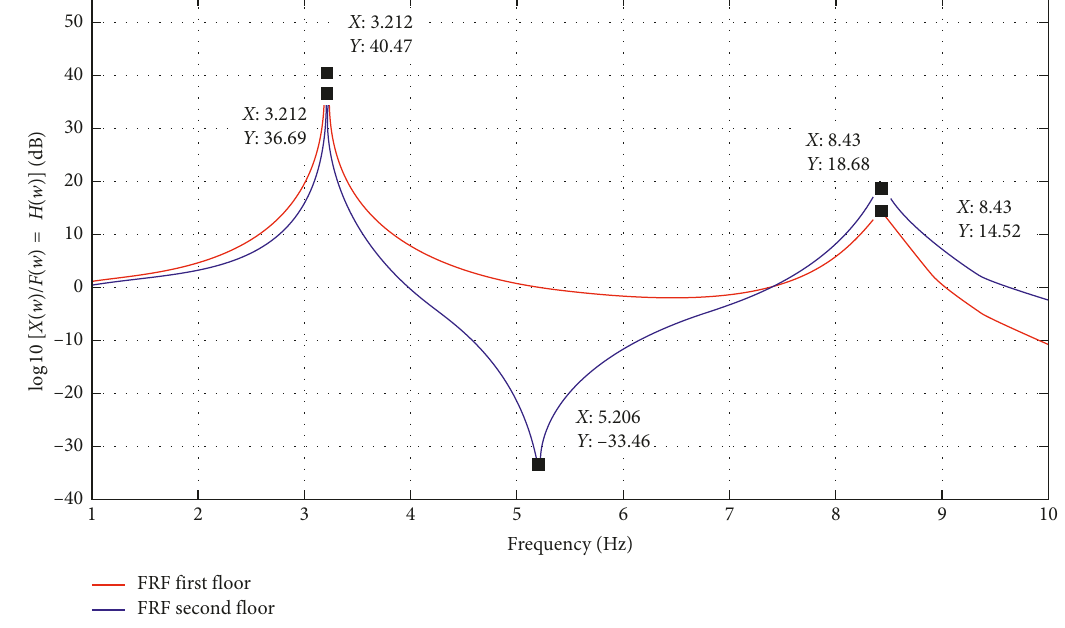
Figure 11: FRF analytical obtained by the system transfer functions.